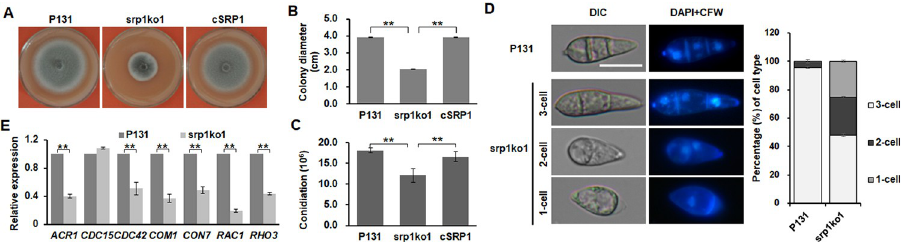
Fig 1. MoSrp1 is important for vegetative growth, conidia morphology, and conidiation. (A) Colonies formed by the wild-type (WT) strain P131, the Δ Mosrp1 mutant srp1ko1, and its complementation transformant cSRP1 on OTA plates cultured for 5 d. (B) Statistics on colony diameters of strains P131, srp1ko1, and cSRP1 at 5 dpi. The mean and standard deviations were calculated based on three independent experiments each with three plates. Asterisk marks significant difference of the mutant from P131 and cSRP1 using t -test (p < 0.05). (C) Conidia per petri dish produced by strains P131, srp1ko1, and cSRP1. The mean and standard deviations were calculated based on three independent experiments each with three plates. Asterisk marks a significant difference of srp1ko1 from WT and cSRP1 using t -test (p < 0.05). (D) Conidia of strains P131 and srp1ko1 co-stained with CFW and DAPI. At the right of the images were percentages of conidia with 1-, 2-, and 3-cell formed by strains P131 and srp1ko1. At least 300 conidia were calculated for each strain. Bar, 10 μ m. (E) Relative expression level of seven cell cycle-related genes in vegetative hyphae of strains P131 and srp1ko1. The gene expression level in P131 was arbitrarily set to 1. The actin gene was used as the internal control. The data were obtained from three replicates. Asterisk marks a significant difference of srp1ko1 from P131 using t -test (p <